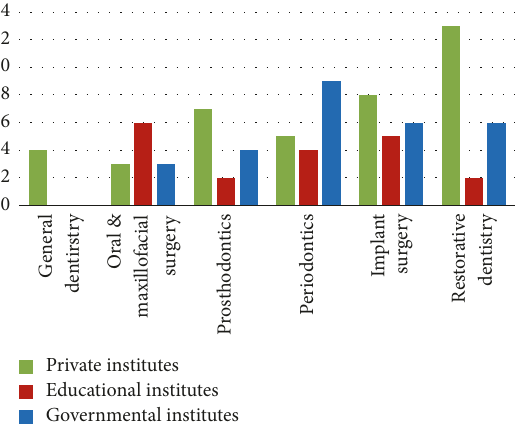
Figure 1: Clinician specialty of respondents.